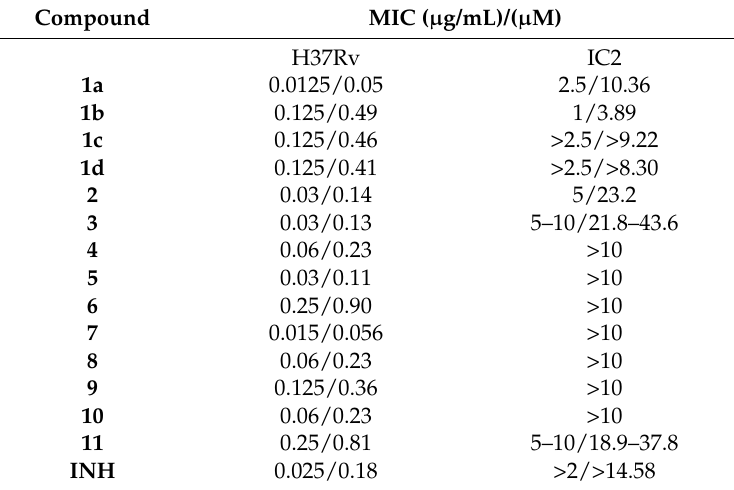
Table 9. MIC of isoniazid derivatives against M.tb MDR isolate IC2.